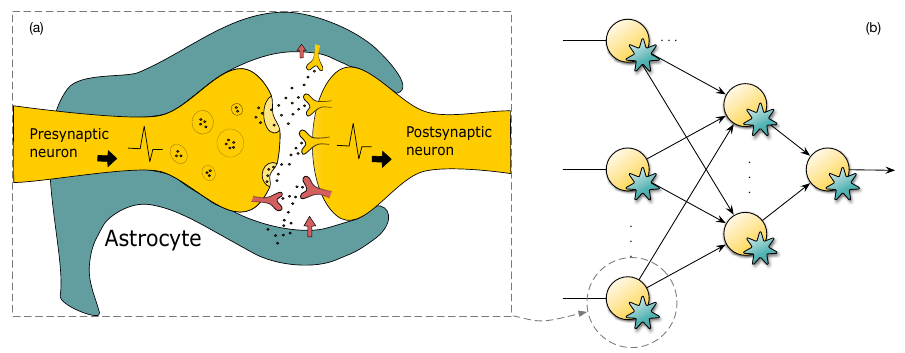
Figure 1. ( a ) Scheme of tripartite synapse in the brain. ( b ) ANAN structure, where artificial astrocytes and neurons are represented by green and yellow colors,